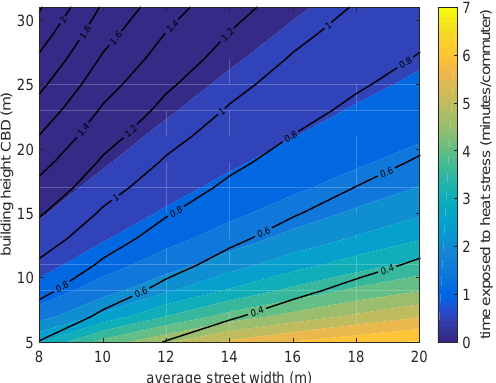
Figure 11. Time exposed to heat stress ( ODH ave ) in minutes per commuter as a function of building height in the CBD and street